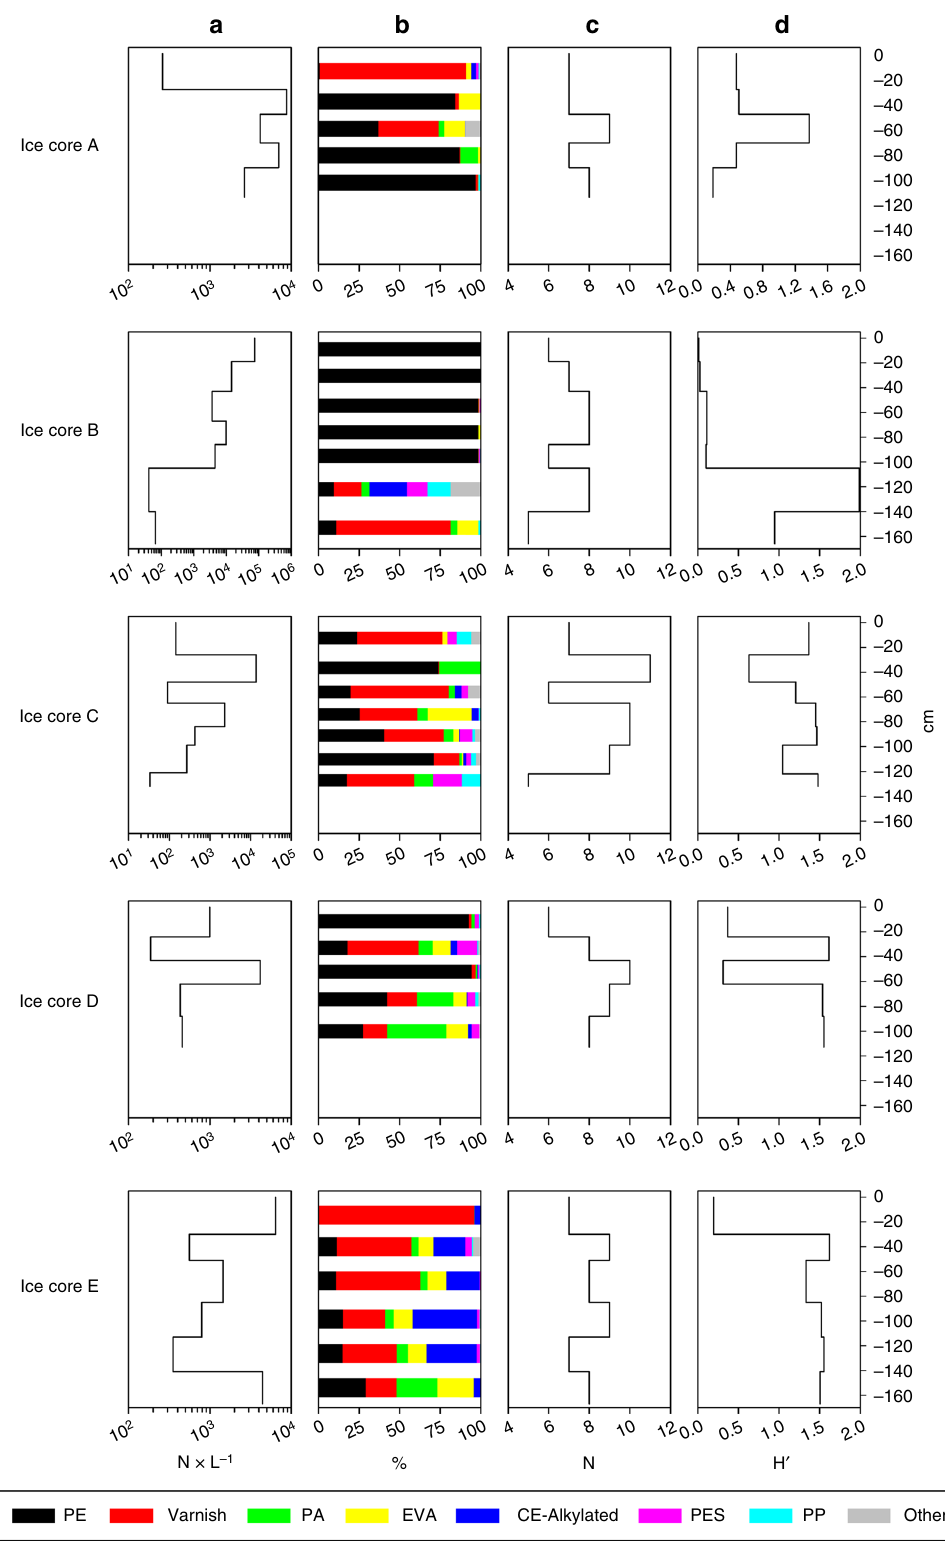
Fig. 5 Vertical distribution of microplastic in sea ice cores. a refers to the concentration of microplastic particles (in N×L − 1 ) for each core. b refers to the polymer composition for each core: polyethylene (PE), varnish (including polyurethane and polyacrylate), polyamide (PA), ethylene vinyl acetate (EVA), cellulose acetate (CE-Alkylated), polyester (PES) and polypropylene (PP) and others. c refers to polymer richness (N), and d refers to the Shannon – Wiener index (H'). Steps indicate the sampling horizons taken for each